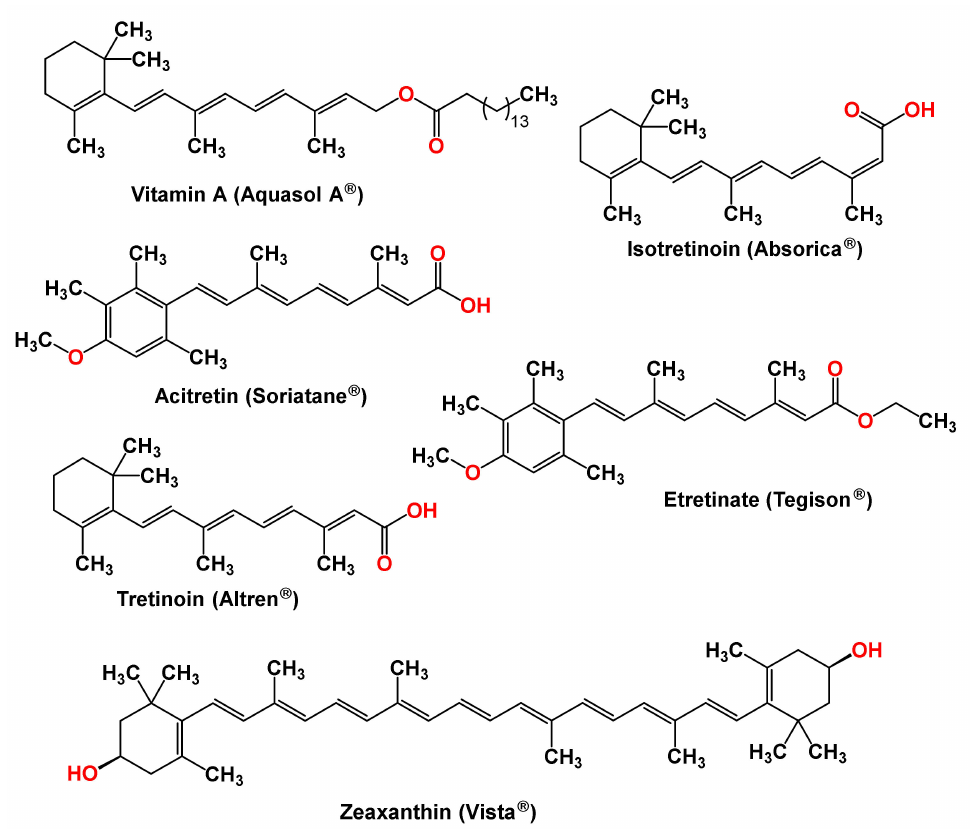
Figure 5. Structures of marketed carotenoid-based drugs and